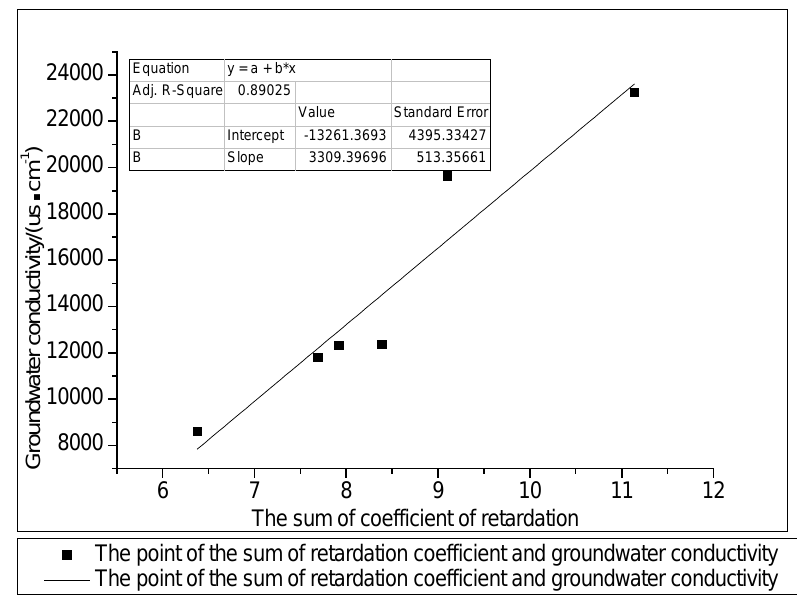
Figure 6. ( a ) Correlation between the coefficient of retardation and the milliequivalent percentage of the ionic components; ( b ) Correlation between the sum of retardation coefficients and groundwater conductivity.